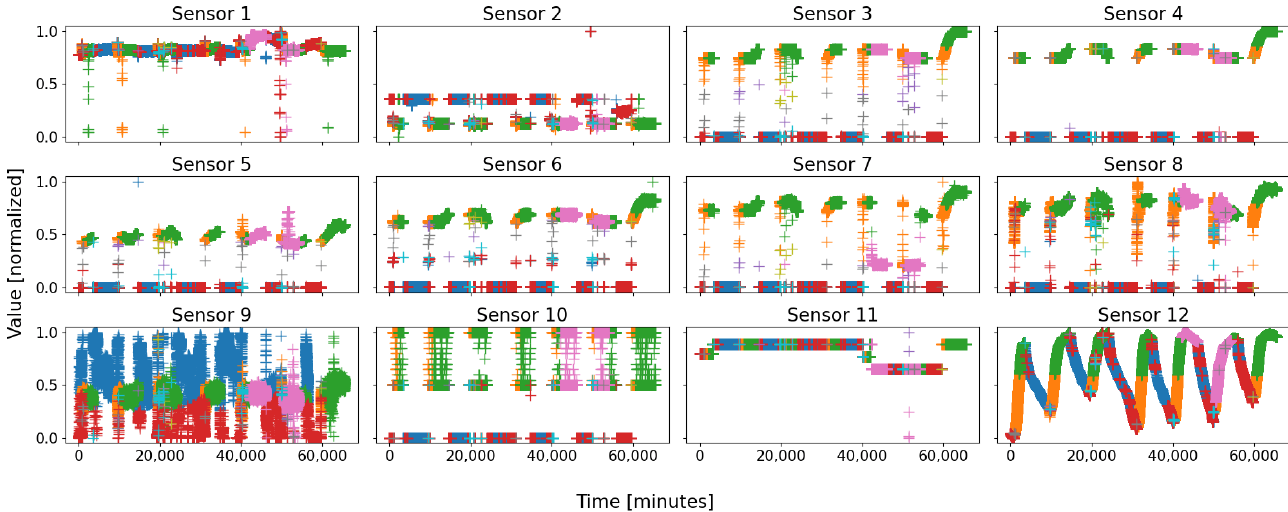
Figure 10. Battery 2’s twelve clustered sensors of the rightmost column of Figure 7. In the figure, five clusters are distinguishable: orange, green, blue, red, and pink.